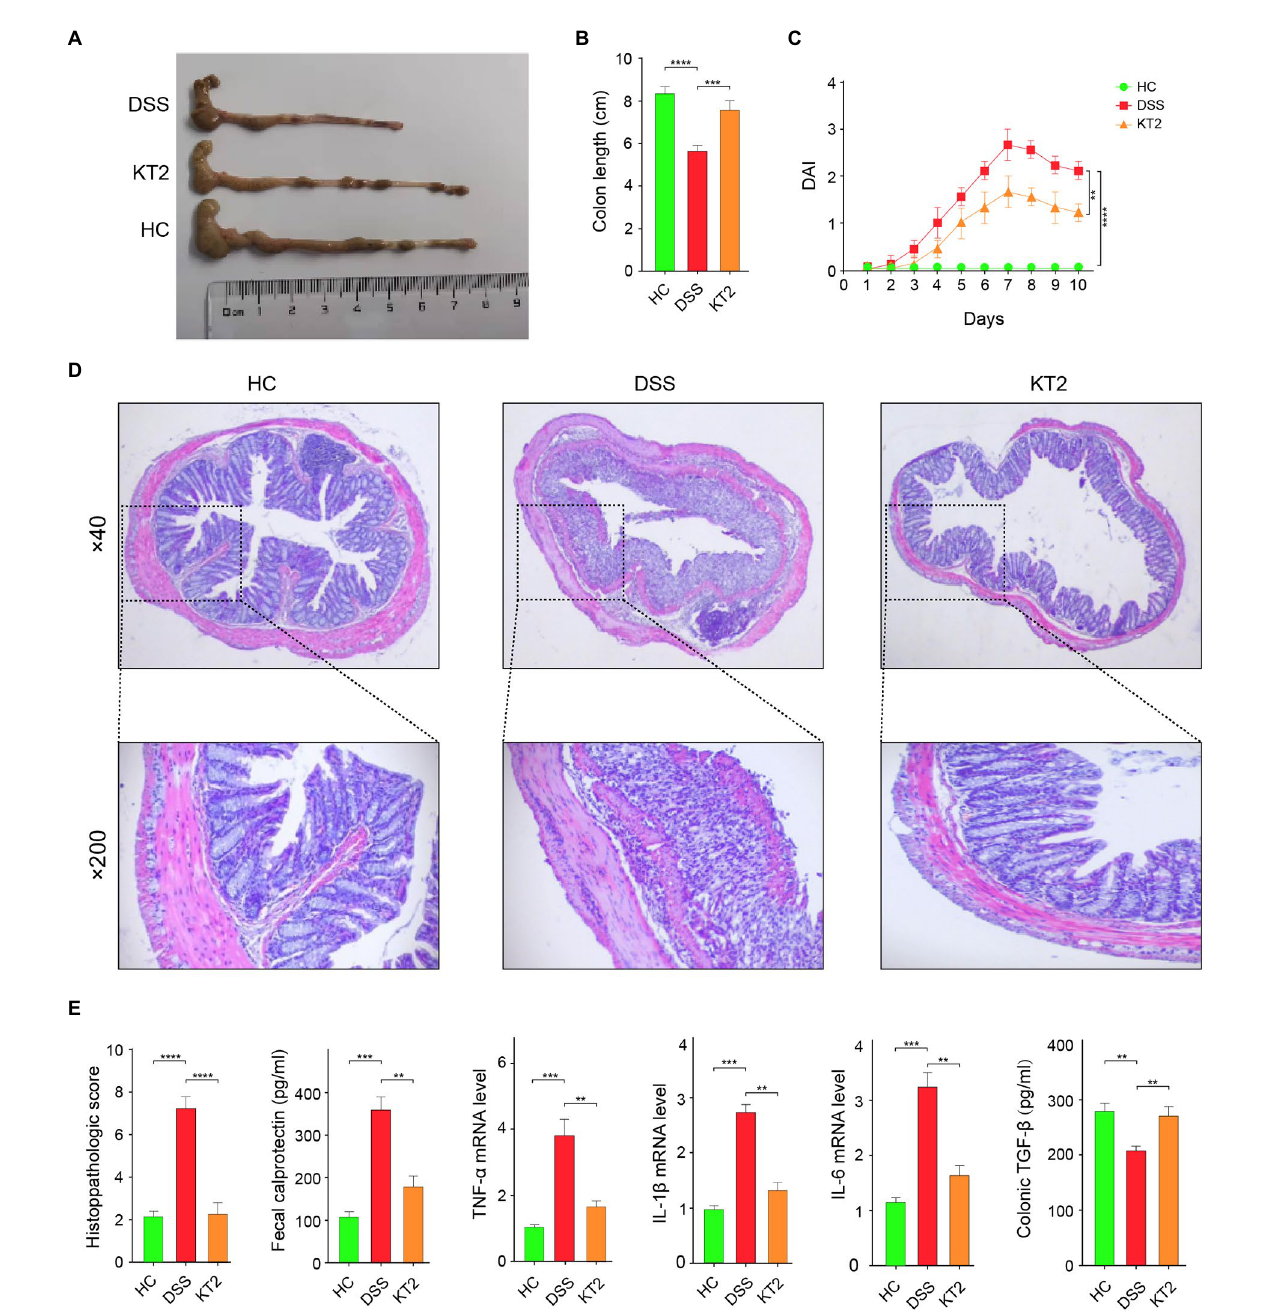
FIGURE 1 Protective effects of KT2 peptide on UC in mice. (A) Colon length in different groups. (B) Statistical analysis of colon length in different groups. (C) Statistical analysis of DAI scores. (D) Pathological changes in colon tissue were assessed using H&E staining. Upper panel shows mouse colon pathology at 40×, lower panel shows mouse colon pathology at 200×. (E) Histopathological score and fecal calprotectin, TNF- α , IL-6 , and IL-1 β levels examined by quantitative RT-PCR (qRT-PCR), and colon TGF- β level examined by ELISA, from left to right. ∗ p < 0.05, ∗∗ p < 0.01, and ∗∗∗ p <